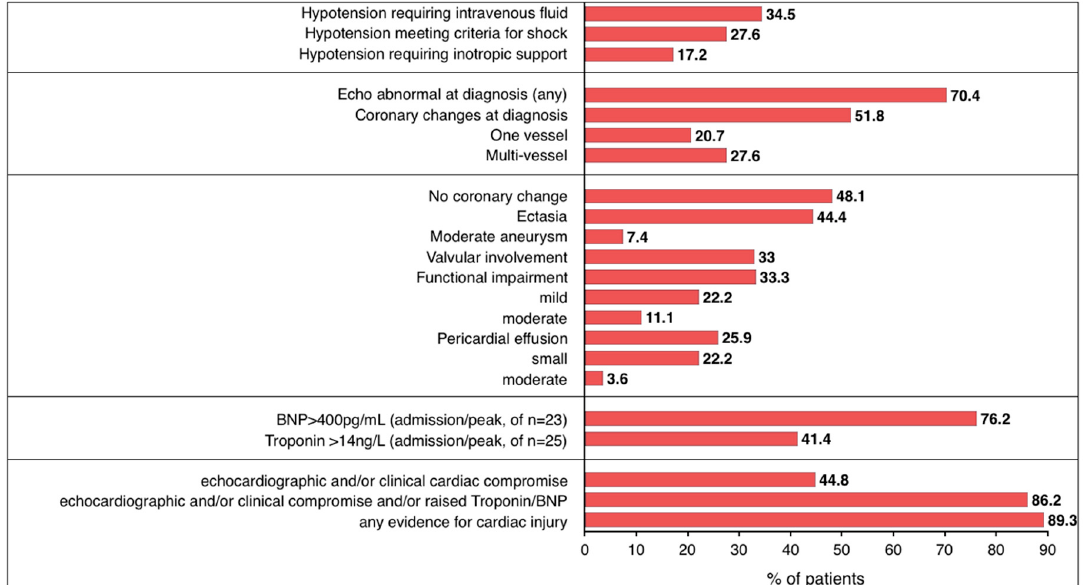
Figure 6. Illustration of clinical, echocardiographic and biochemical evidence of cardiac injury in children with paediatric multisystem inflammatory syndrome temporally associated with SARS-CoV-2. Composite parameters as declared. Troponin—Troponin T, BNP—Brain Natriuretic Peptide. Where data are available for n < 29, n is specified separately.